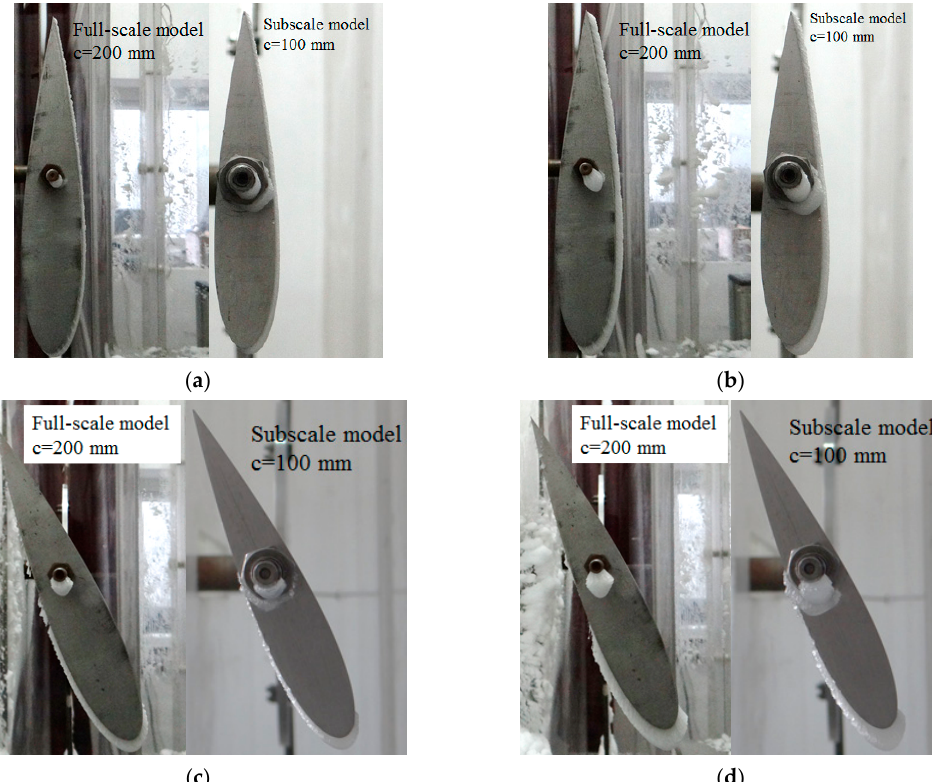
Figure 7. Icing shapes for the subscale model and full-scale model under different conditions: ( a ) No.1 condition; ( b ) No.2 condition; ( c ) No.11 condition; ( d ) No.12 condition.